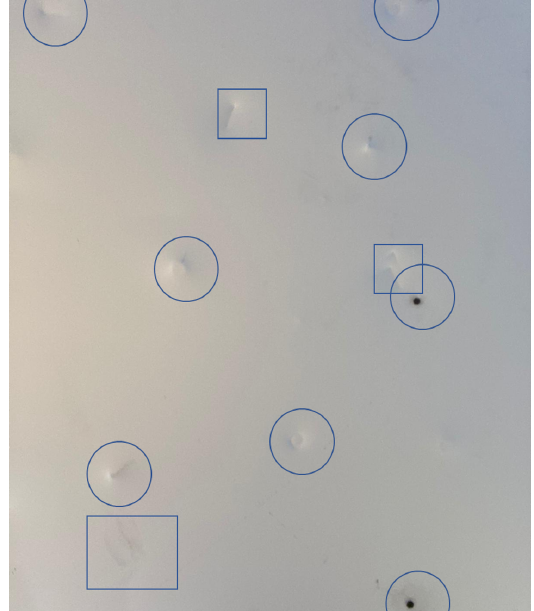
Figure 9. Result of the flaw detection algorithm performed on a 3D